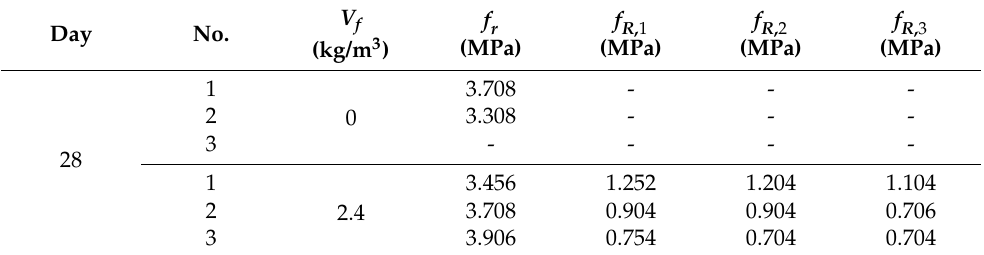
Table 5. Concrete tensile test results.